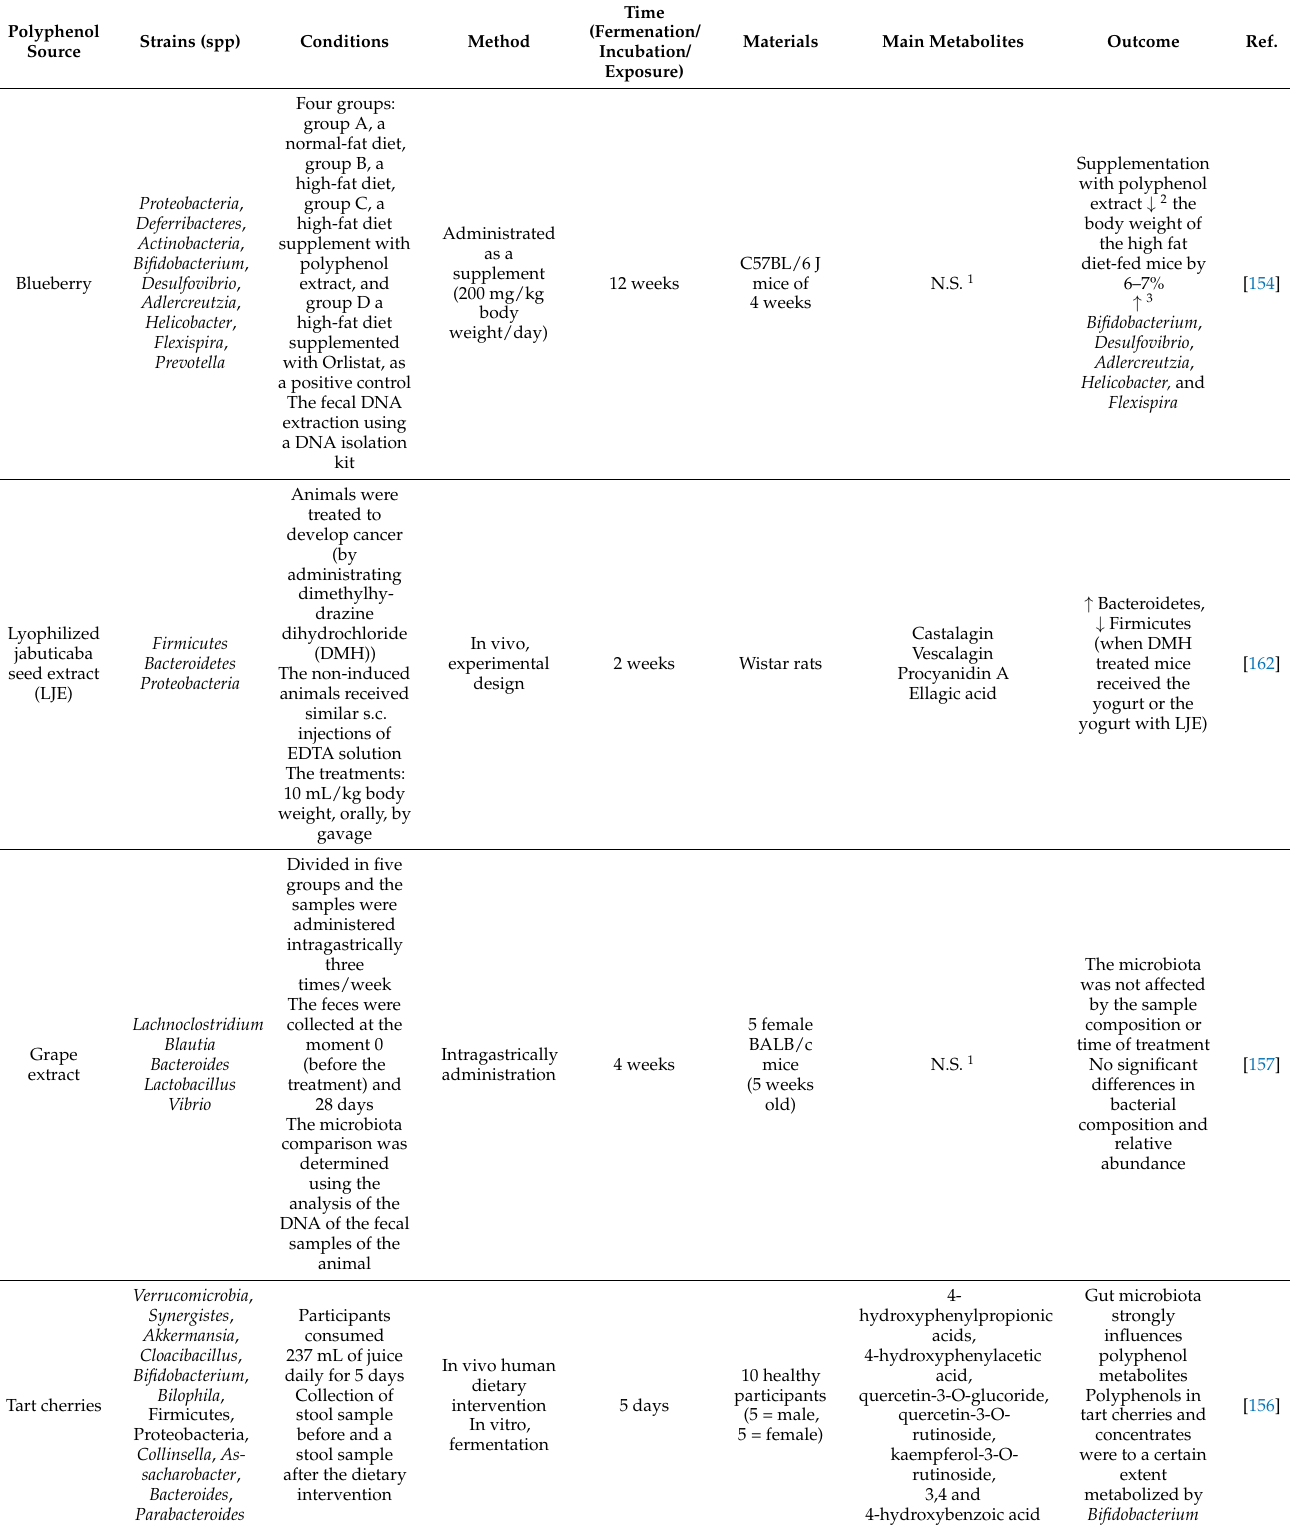
Table 3. In vivo modulation of gut microbiota through polyphenol